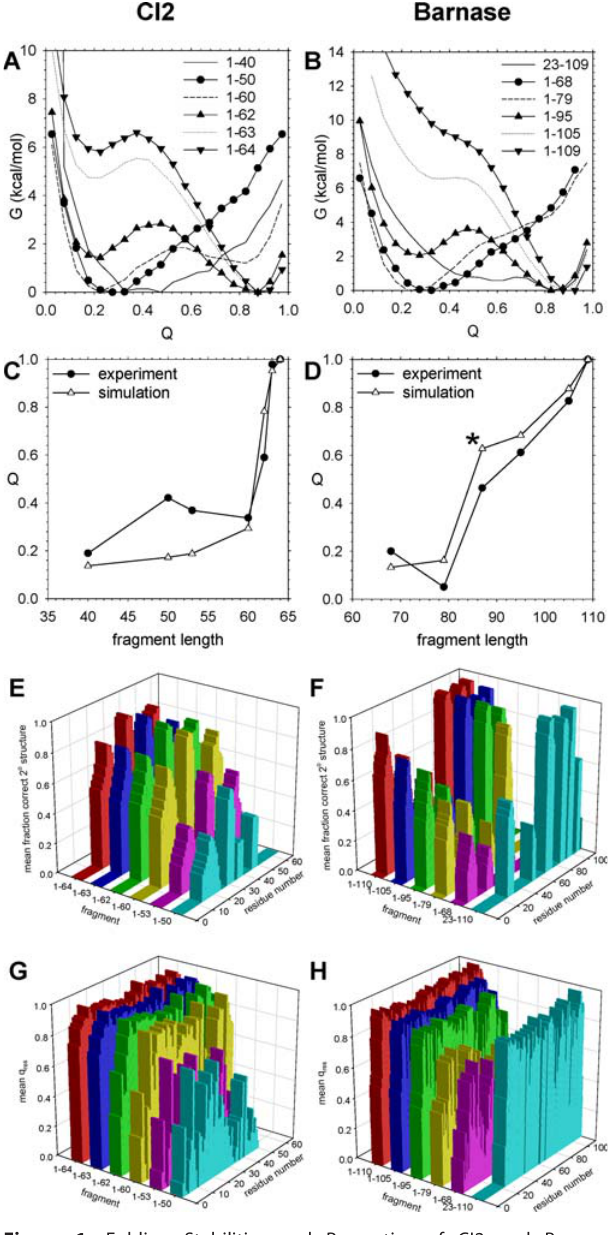
Figure 1. Folding Stabilities and Properties of CI2 and Barnase Fragments (A) Plot of free energy, G, versus Q at 300 K for six fragments of CI2. (B) Same as (A), but showing results for barnase. (C) Mean value of Q computed from simulations for CI2 compared with fluorescence intensities taken from Figure 10 of [34]. (D) Same as (C), but for barnase, and compared with fluorescence intensities taken from Table 1 of [36]. (E) Fractional population of correct secondary structure at all residues in CI2 fragments at 278 K. (F) Same as (E), but for barnase. (G) Mean values of Q res at all residues in CI2 fragments at 278 K. (H) Same as (G), but for barnase. DOI: